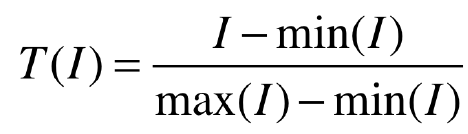
Figure 1. Equation to define T(I).